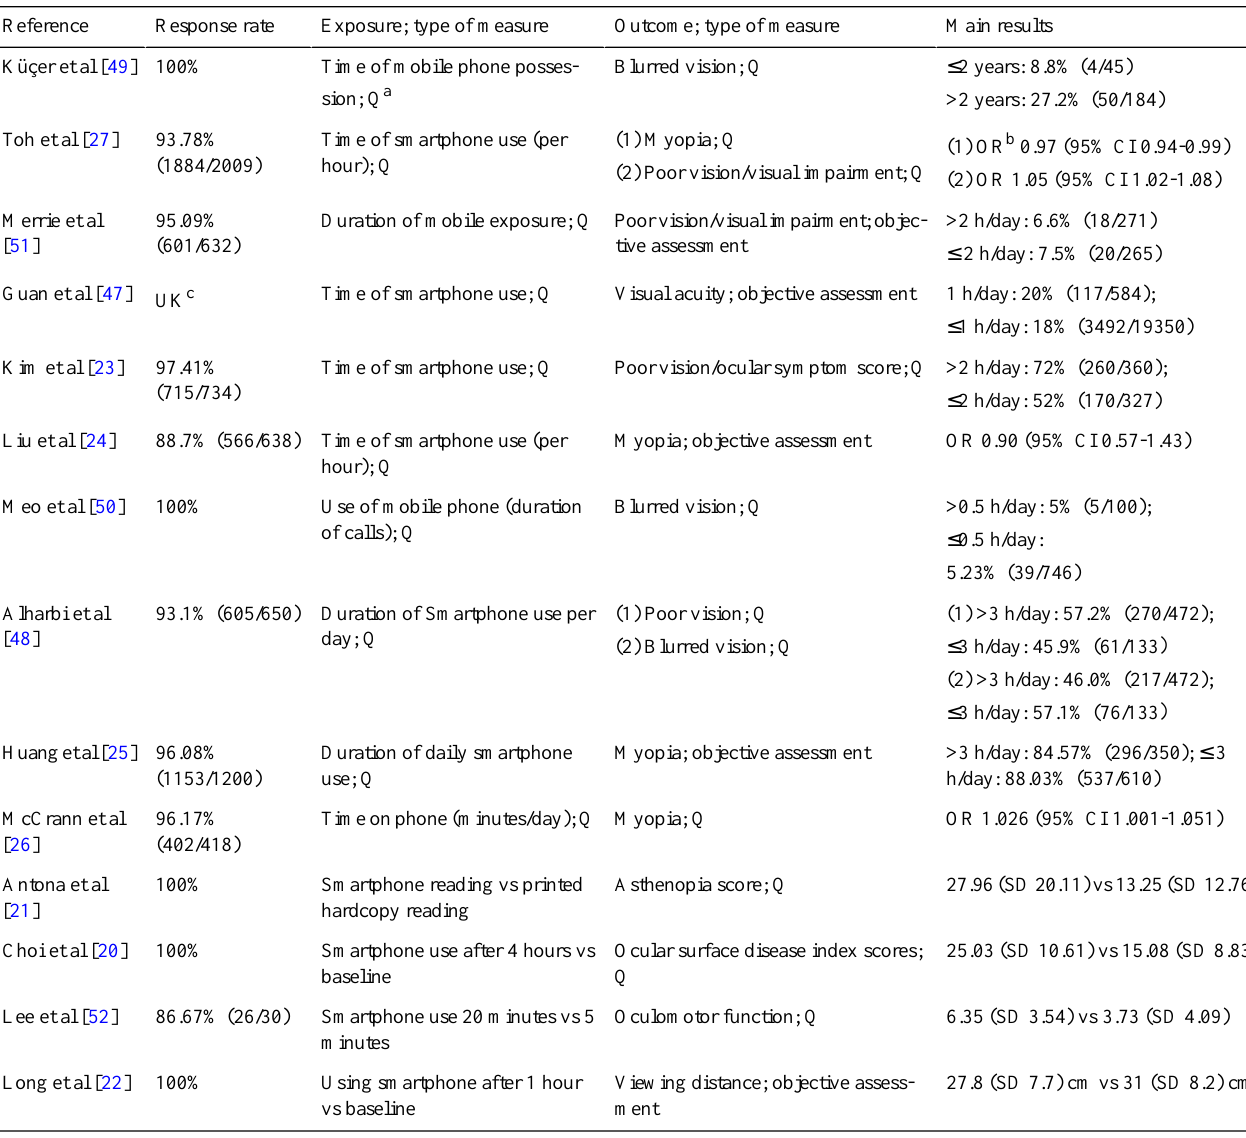
Table 2. Outcomes and results of the included